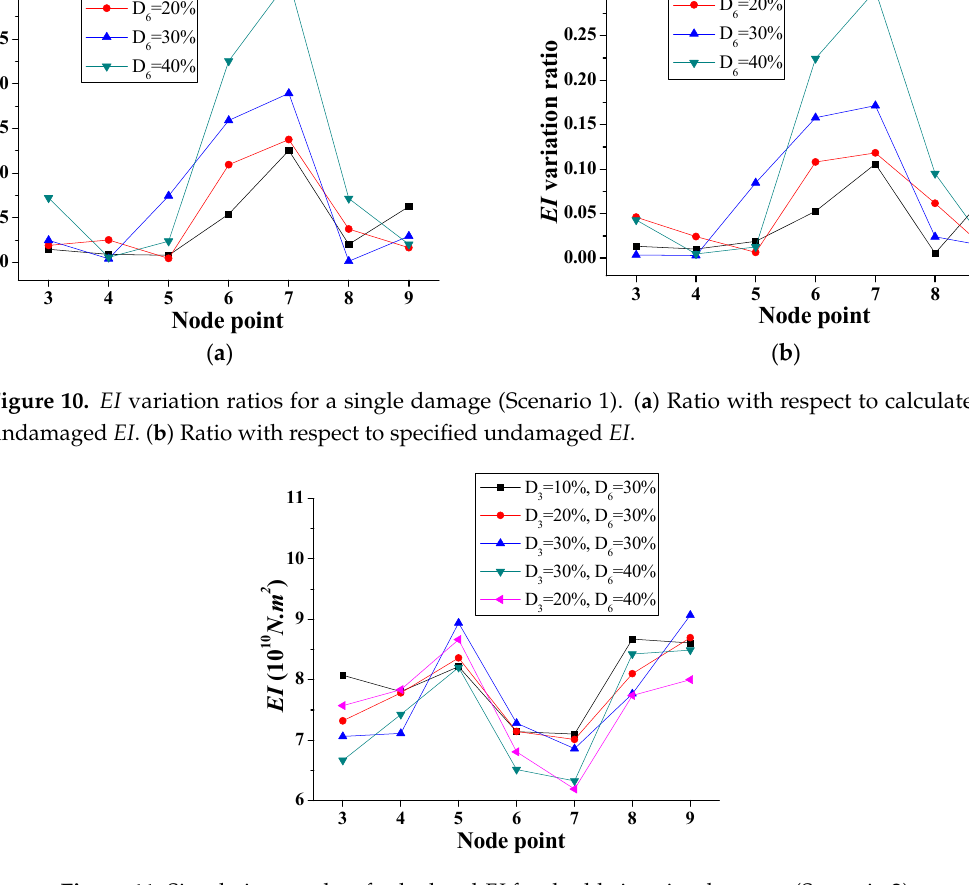
Figure 11. Simulation results of calculated EI for double interior damages (Scenario 2).